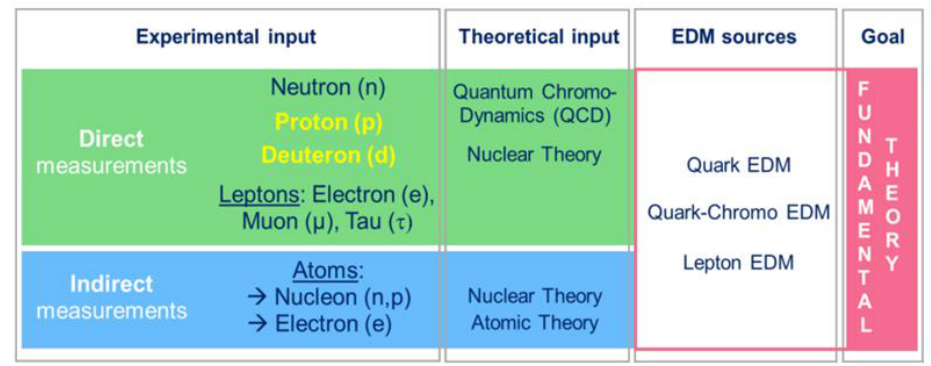
Figure 4. Schematic connection between experiment and a fundamental theory as the ultimate goal of EDM investigations. There are two major paths to experimentally search for EDMs: direct measurements, which study a sole particle species, and indirect measurements, which use atoms or molecules (or even bulk matter). Although indirect experiments have resulted in impressive upper limits, direct investigations are clearly preferable, since they will be much easier to interpret.